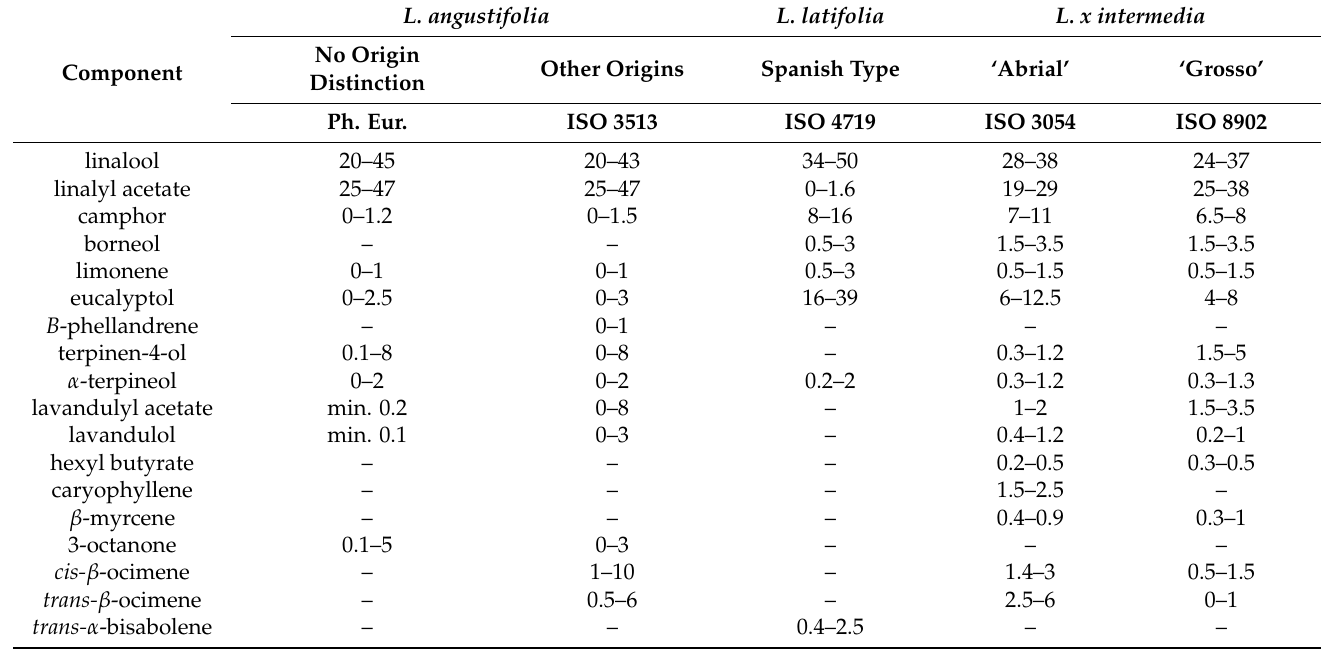
Table 1. Normative content requirements (in %) for L. angustifolia , L. latifolia , and L. x intermedia essential oil chromatographic